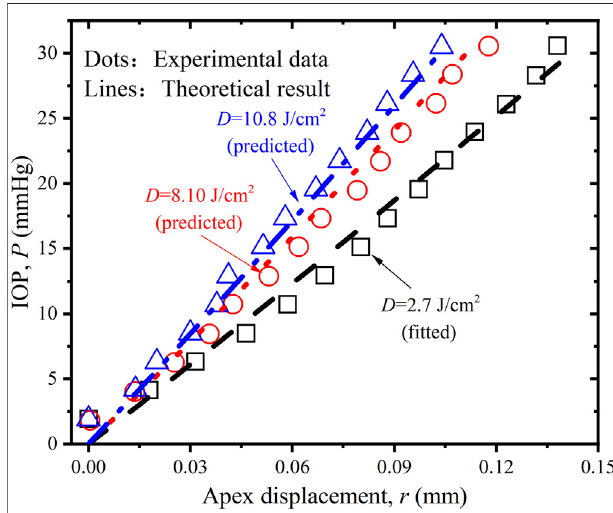
FIGURE 6 | Comparison of the P - r relations of porcine cornea between the experimental data (Boschetti et al., 2021), predicted and simulated results when D (cid:1) 2 . 7J/cm 2 , 8 . 10J/cm 2 and 10 . 8J/cm 2